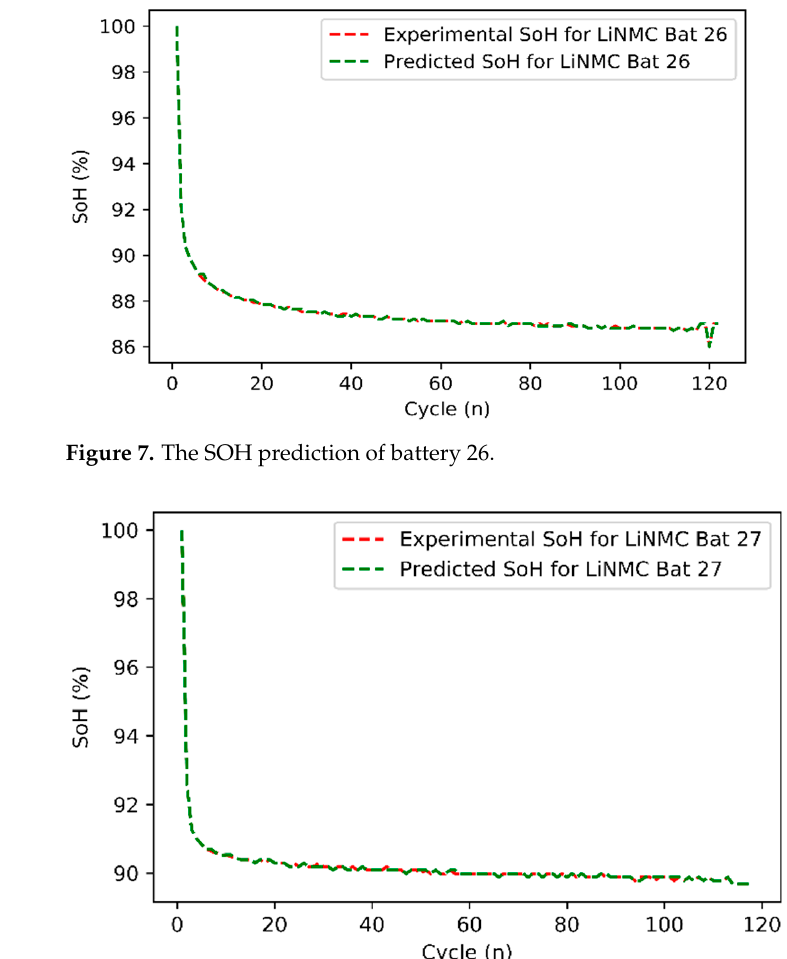
Figure 6. The SOH prediction of battery 25.